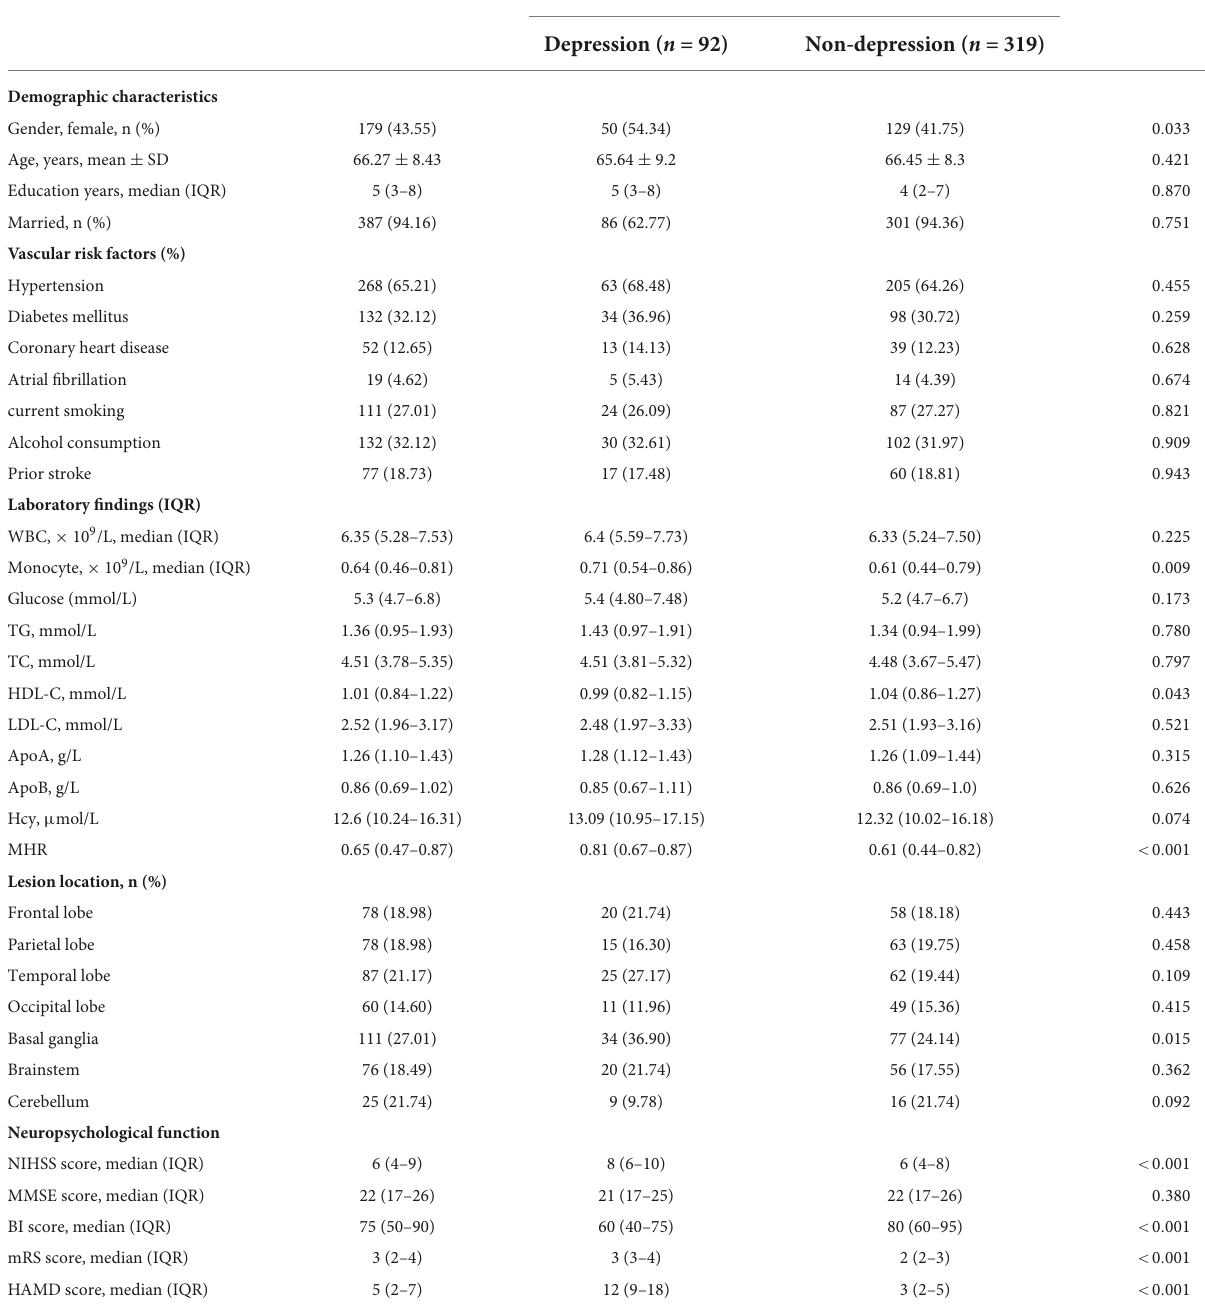
TABLE 1 Clinical and demographic characteristics of patients with PSD and